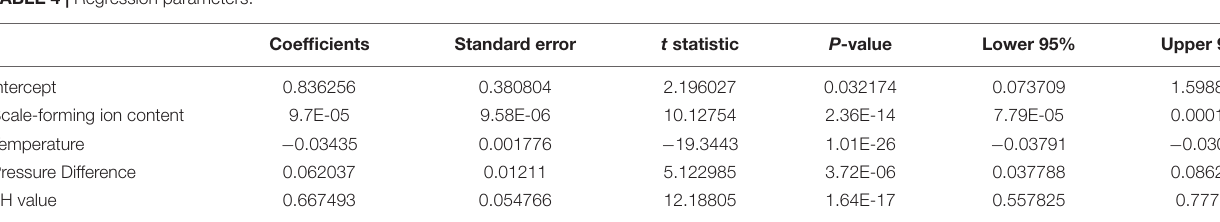
FIGURE 5 | The relationship between scale-forming ion content and precipitation capacity. TABLE 4 | Regression